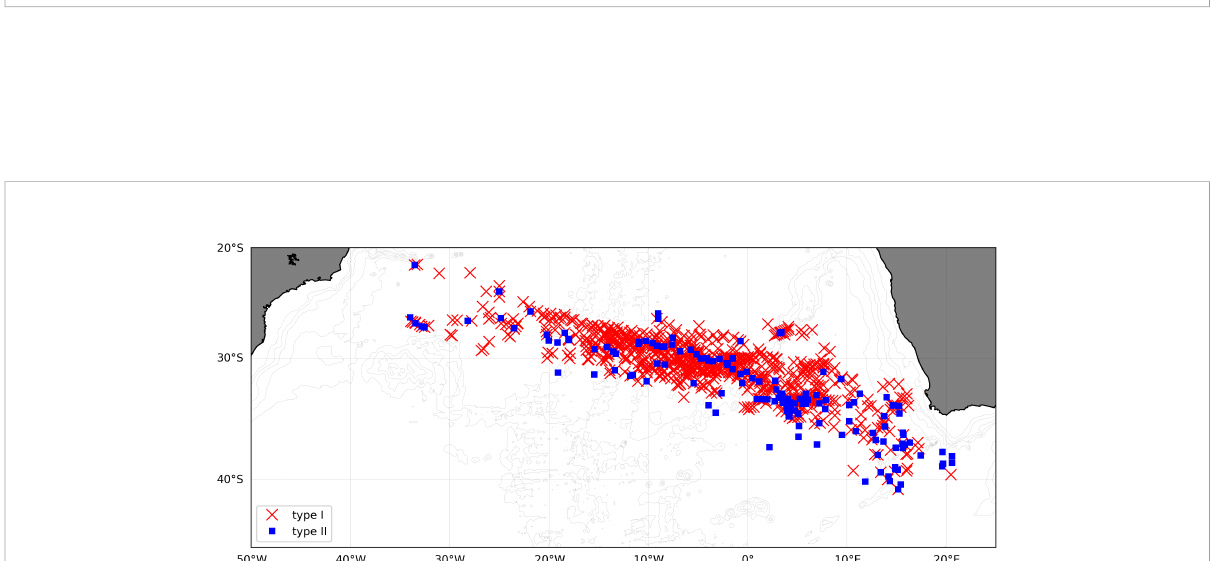
FIGURE 5 Map of occurrence of mode waters in Agulhas rings. Both mode water varieties were detected from the Cape Basin until the western basin. The bottom topography is shown in the background in faded gray